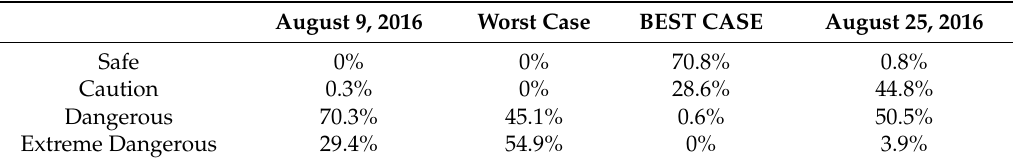
Table 4. The percentages of the route rated as safe, caution, dangerous and extremely dangerous for each day and scenario.